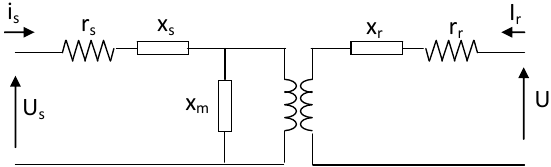
Figure 4. Equivalent circuit of a wound rotor induction generator .